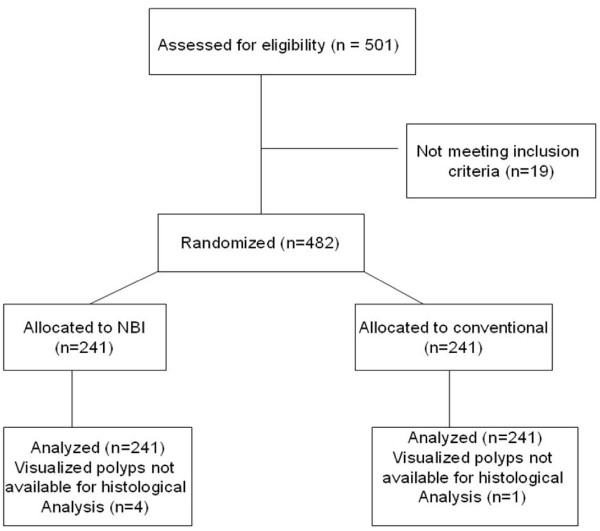
Flow of participants through each stage of the randomized trial.